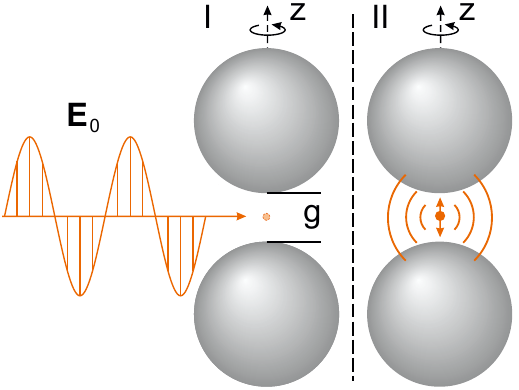
Figure 1: Schematic image of the excitation and decay phases. First, the emitter is excited by a plane wave polarized along the z -axis impinging on the NP dimer (I); then, the emitter’s dipole field interacts with the electromagnetic states provided by the dimer